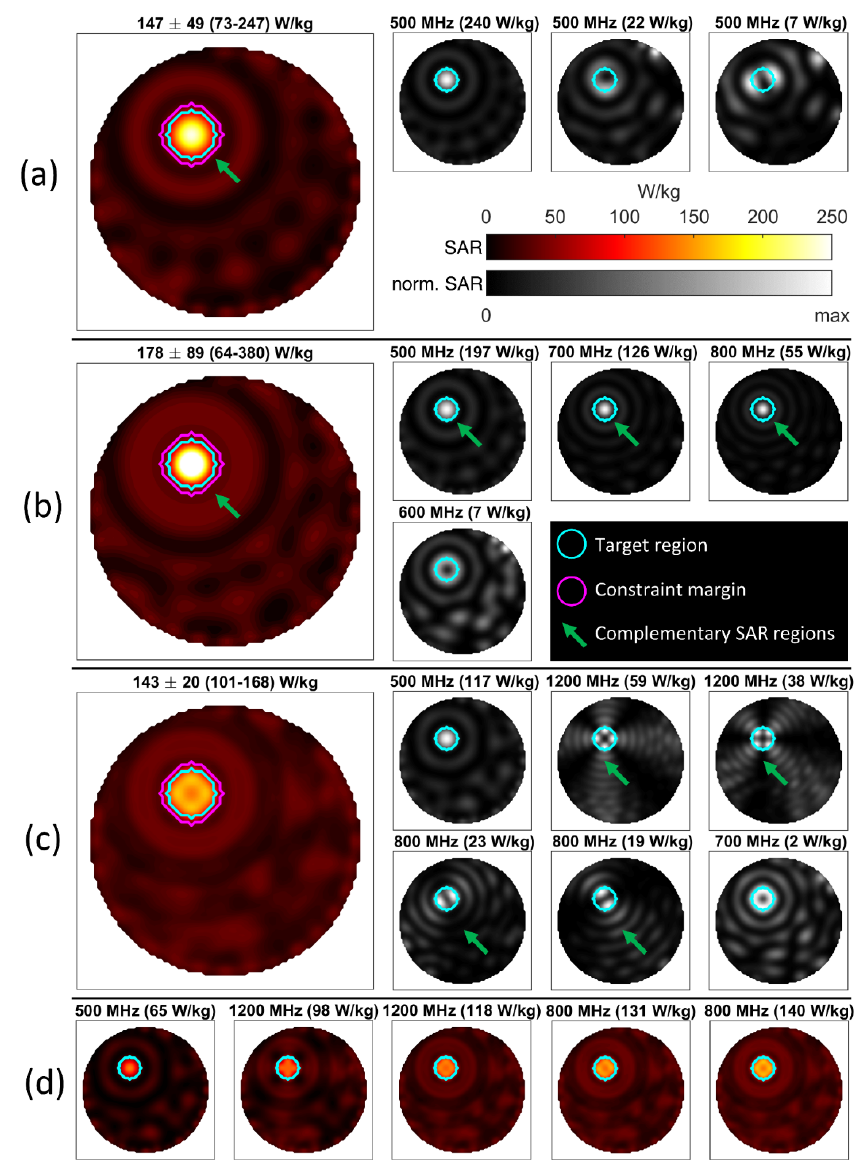
Figure 4. Demonstration of shaped RF power deposition in the 2D water sample. The target region is delineated with a cyan contour (r = 19 mm), and the region between the cyan and magenta contour indicates a “safety margin” where no constraints are enforced. ( a ) Optimization result using only 500 MHz sources minimizing the 2-norm. The large plot on the left details the total achieved local SAR deposition, with statistical measures of SAR within the target region detailed in the header (Mean ± SD (Min–Max)). The smaller plots to the right show the contributions of multiple time-multiplexed modes scaled to their respective maximum, with their respective peak contribution inside the target region shown in the header. In ( b ), all frequencies between 500 and 1500 MHz could be used, resulting in an improved power deposition pattern. The green arrows indicate a region where SAR in the constrained regions is spread out between the different frequencies, which demonstrates a key principle of the proposed algorithm. For ( c ), the optimization was set to minimize the worst-case deviation from the target. This resulted in a much more homogeneous power deposition, albeit with lower mean and peak values. Again, all excitations contributed to the target region but occupied complementary regions outside it as indicated by arrows. The image succession in ( d ) shows the cumulative effects of the first five excitations from (c) to demonstrate how the different patterns build up the final superposition. Here, the resulting mean value is given in the header.